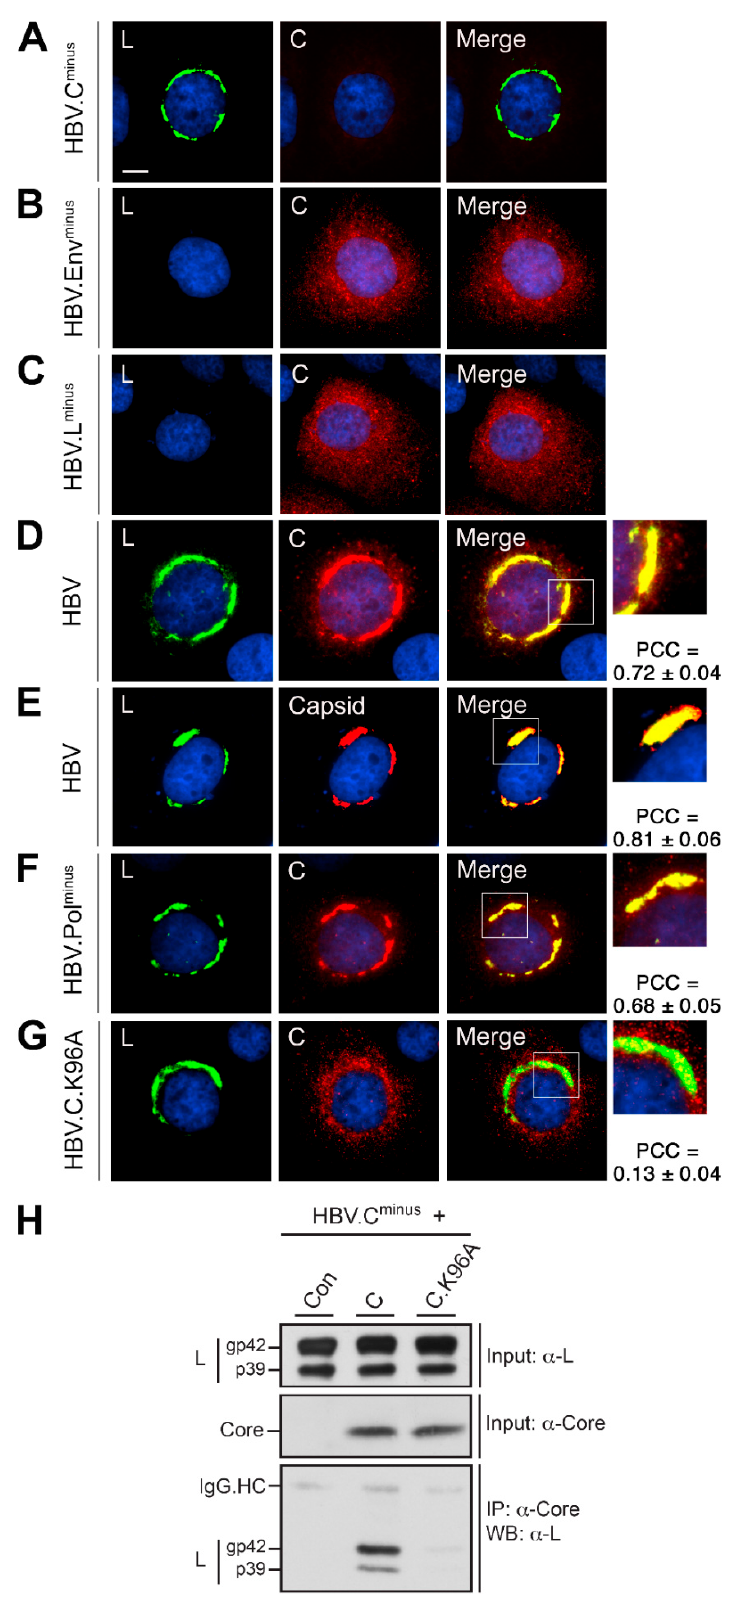
Figure 2. HBV L recruits envelopment-competent core/capsids to ER-associated structures. ( A ) HuH-7 cells were transfected with the wild-type (wt) HBV replicon construct (HBV) or mutant replicons defective in core protein expression (HBV.C minus ), envelope protein expression (HBV.Env minus ), L envelope protein expression (HBV.L minus ) or polymerase activity (HBV.Pol minus ). Cells shown in panel